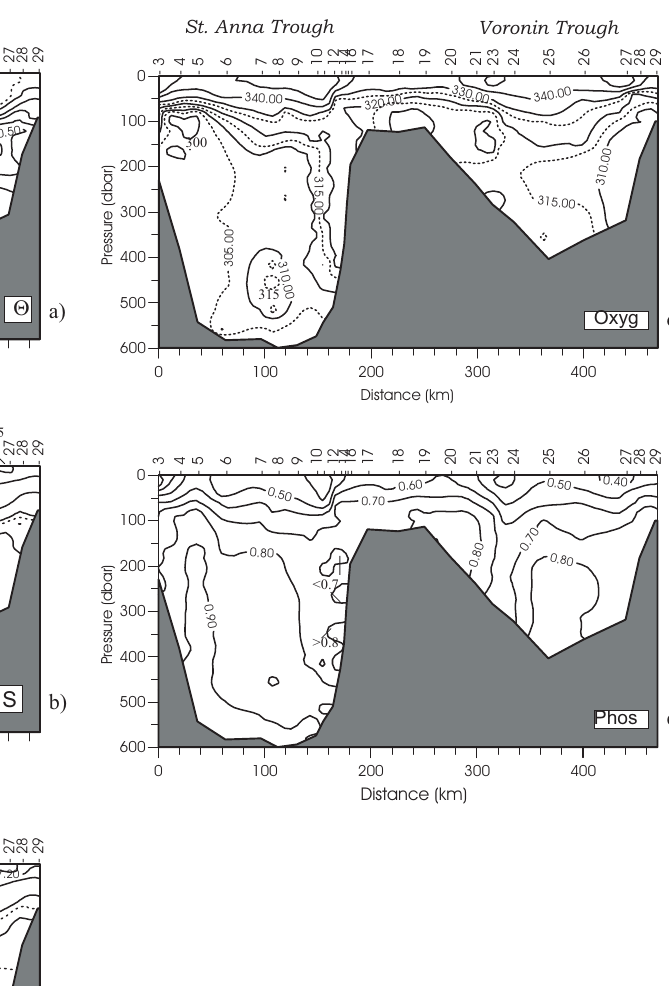
Fig. 2. Vertical distribution of (a) potential temperature ( ◦ C), (b) salinity (psu), (c) density ( σ 0 , kg/m3), (d) oxygen ( µ mol/kg), and (e) phosphate ( µ mol/l) across the St. Anna Trough and Voronin